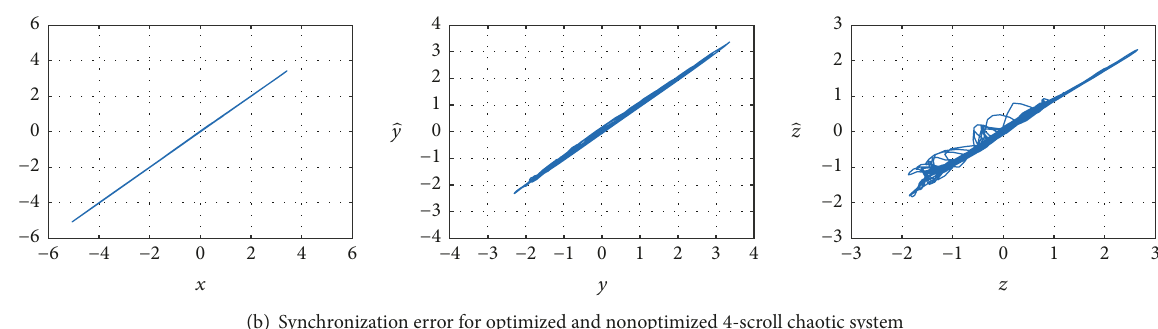
(a) Optimized 4-scroll chaotic system, typical 4-scroll chaotic system without optimization, and typical 4-scroll chaotic system after synchronization ( 𝑥 - 𝑦 plane)